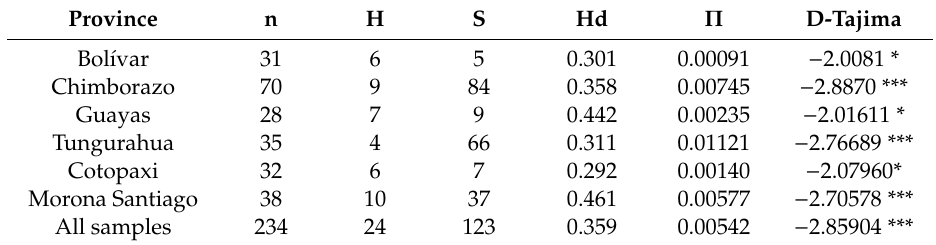
Table 1. Mitochondrial DNA diversity indices of the Ecuadorian Creole chicken